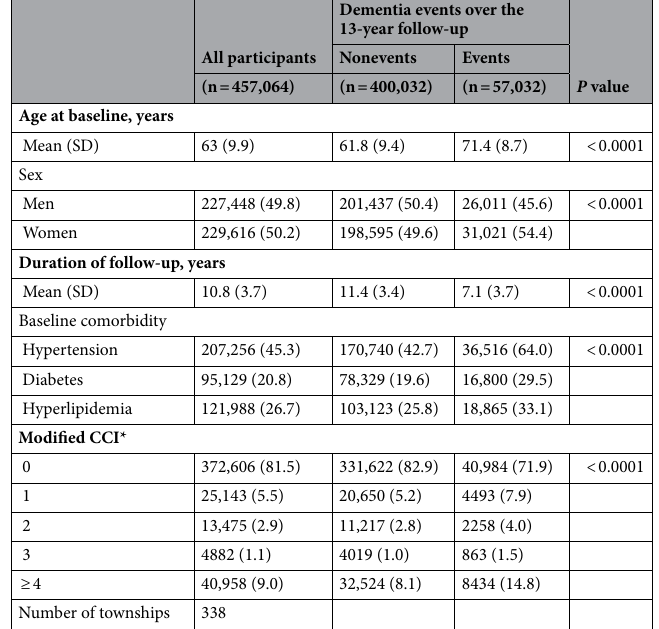
Table 1. Baseline characteristics, n (%). *Modified CCI, which excluded